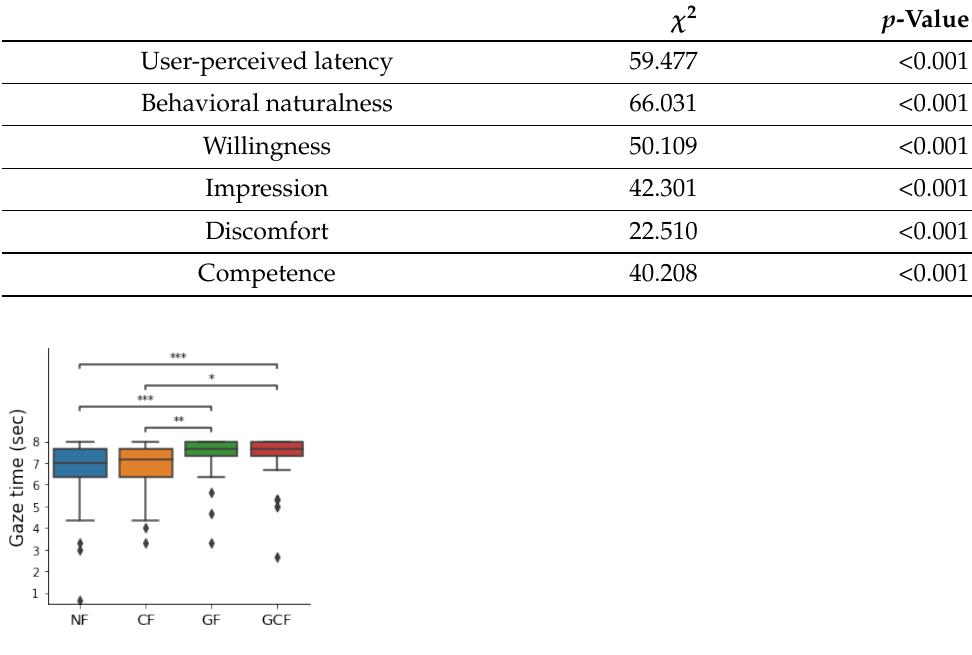
Figure 9. Results of the gaze time during the delayed responses. (*: p < 0.05, **: p < 0.01, ***: p <